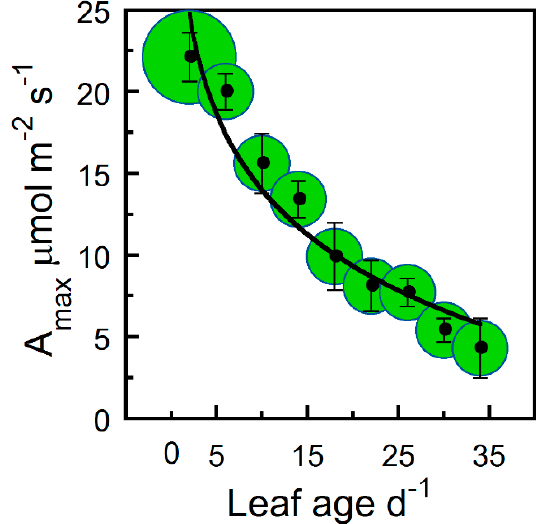
Figure 5. Percent change of photosynthetic physiology to photon flux of 1500 versus 500 μ mol m − 2 s − 1 . ( a ) Percent change of 500 relative to 1500 μ mol m − 2 s − 1 maximum electron transport rate (J max ) and ( b ) percent change of 500 relative to 1500 μ mol m − 2 s − 1 maximum Rubisco carboxylation rate (V cmax ). Solid lines are linear regressions fitted to the entire data set.